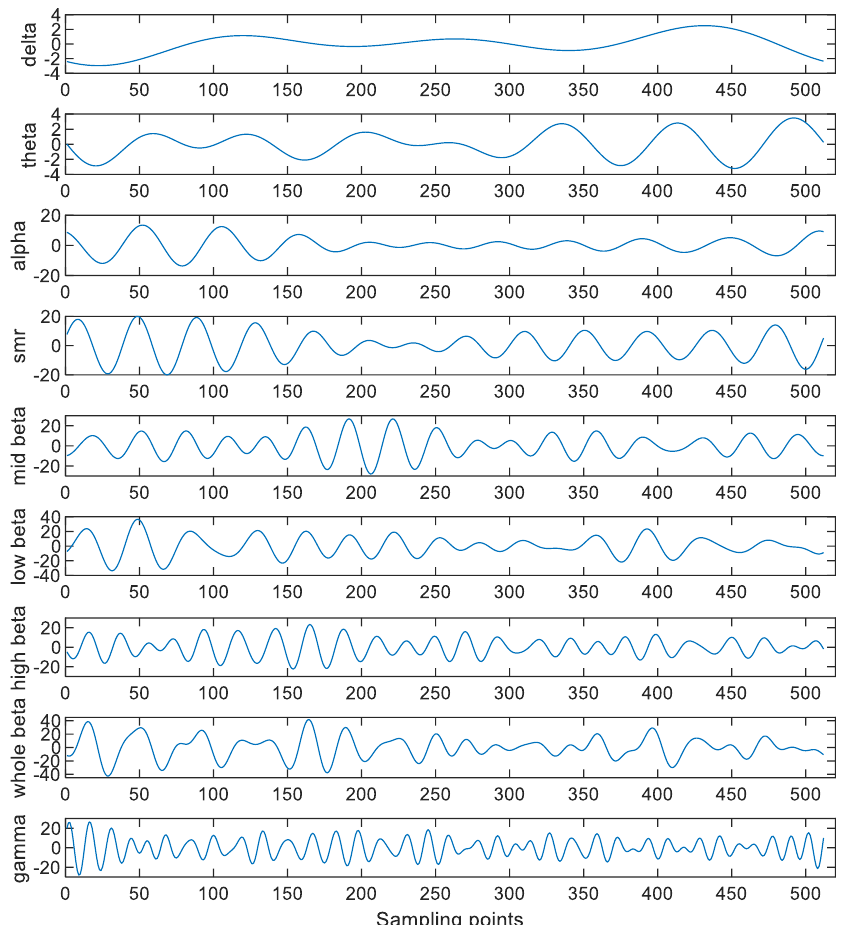
Figure 6. The obtained brain waves when Danny is conducting the drawing activity under the concentration state.